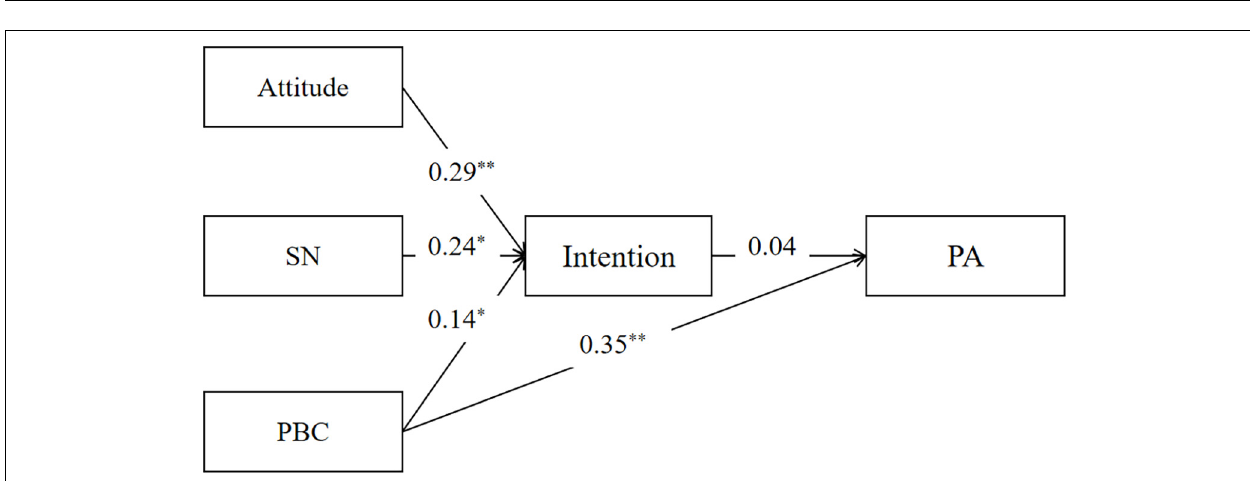
FIGURE 2 | Structural equation model from the TPB constructs to PA among wage earners. SN, subjective norm; PBC, perceived behavioral control; MT, mental toughness; PA, physical activity; * p < 0.05, ** p < 0.01.